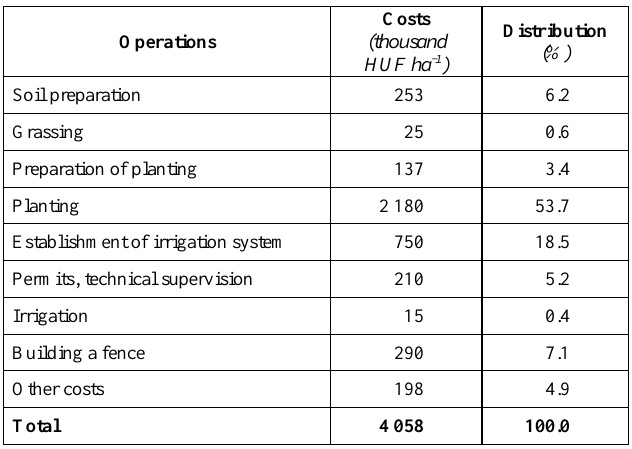
Table 2. Planting costs